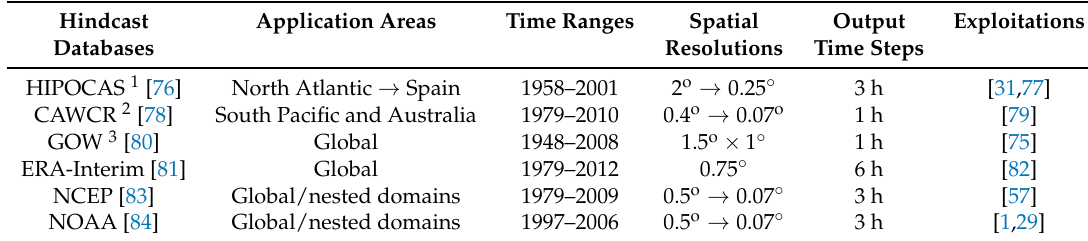
Table 5. Non-exhaustive review of wave hindcast databases and reanalysis archives exploited in wave energy resource